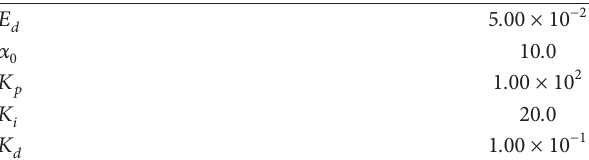
Table 3: Controller